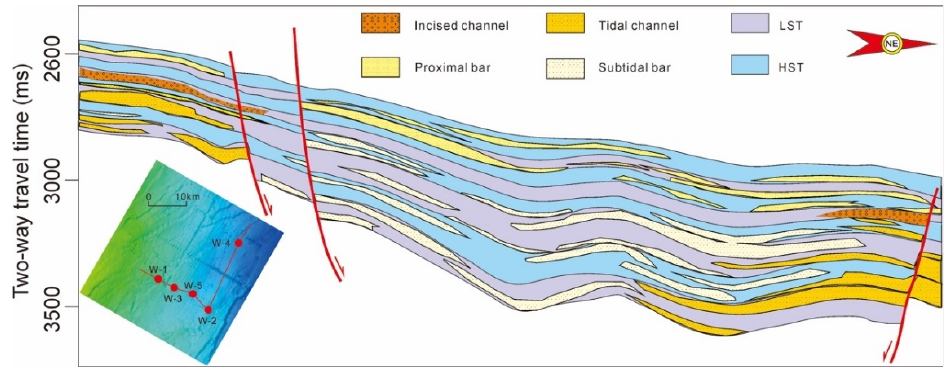
Figure 13. Horizontal distribution of sedimentary facies’ profile of well W-4, W-2, W-5, W-3, and W-1 of the Pinghu Formation.